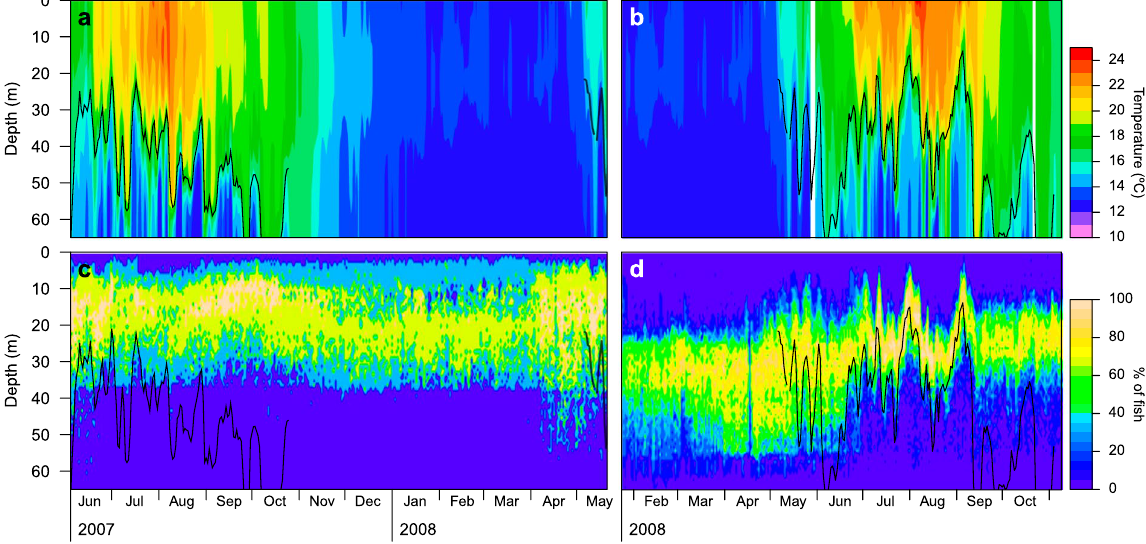
Figure 2. Daily temperature profiles ( a,b ) and vertical distributions of common dentex individuals ( c,d ). The panel in the left ( c ) corresponds to the set of individuals captured in May-June 2007 (n = 3), and the panel in right ( d ) to the set of individuals captured in December 2007-January 2008 (n = 9). Solid lines represent the daily mean depth of the